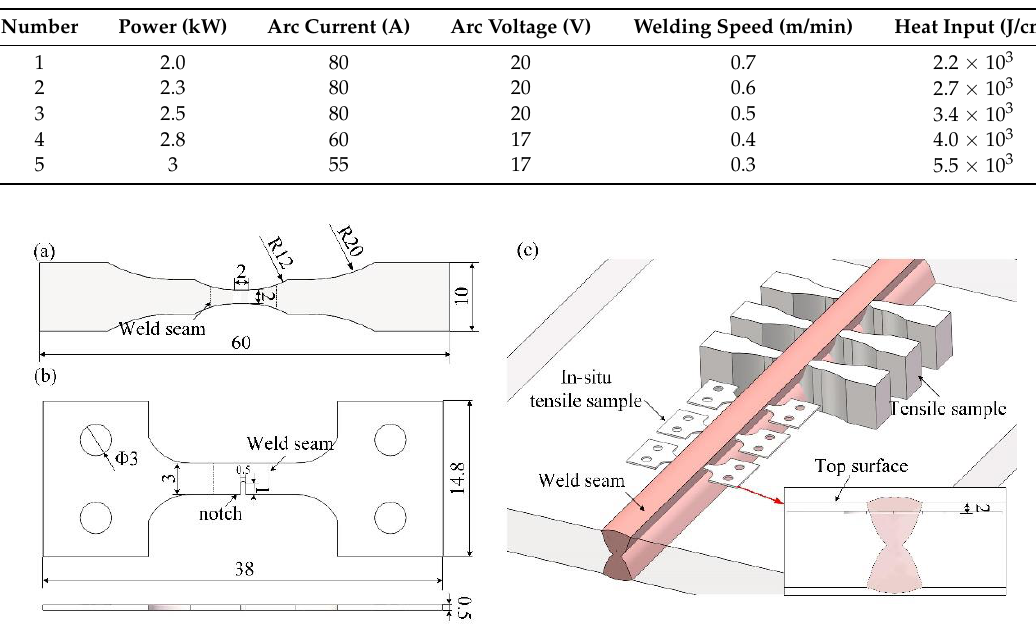
Figure 4. ( a ) Shape and size of butt joint tensile sample; ( b ) Shape and size of in-situ tensile sample; ( c ) Schematic diagram and distribution of tensile samples. (unit: mm)